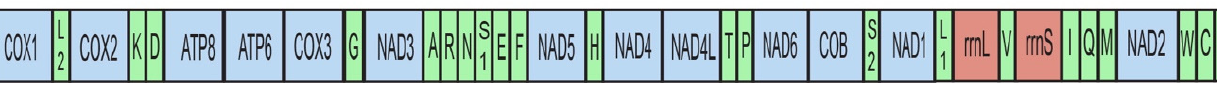
Figure 2. Gene order arrangement of the mitochondrial genome for all stomatopod species used in this study. Blue boxes represent protein coding genes, orange boxes are rRNA genes, and green boxes are tRNA genes. The NAD1, NAD4, NAD4L, NAD5, rrnL, and rrnS genes were in the reverse direction and the rest were in the forward direction.